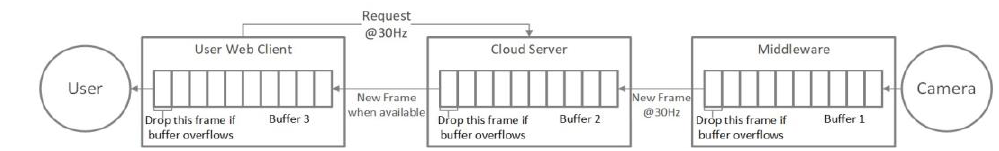
Figure 10. Multi-layer buffers used for reducing network